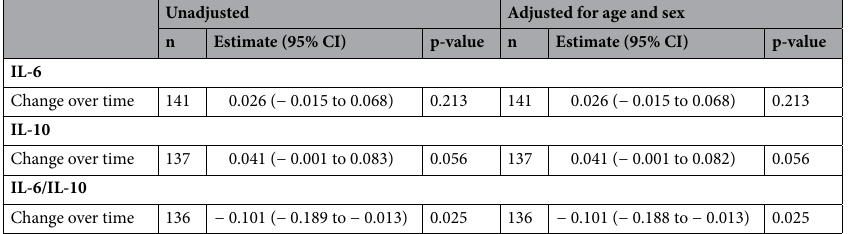
Table 1. Change in IL-6 and IL-10 levels in the whole cohort. Estimates with their 95% confidence intervals (CIs) and p values from the generalized estimating equation (GEE) models. IL‑6 interleukin-6, IL‑10 interleukin-10, n number of observations.